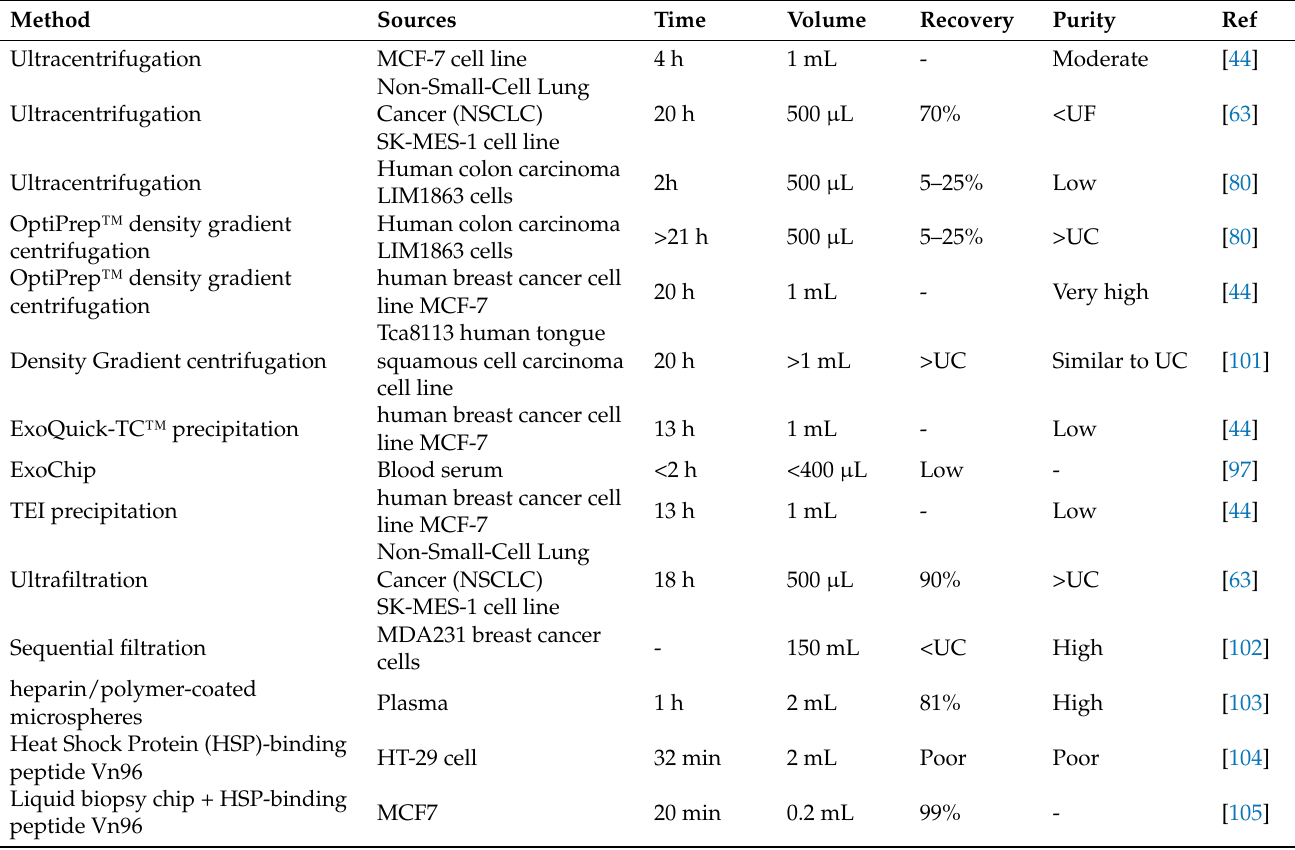
Table 1. Comparison of EV isolation techniques in terms of source, recovery, purity, sample volume and